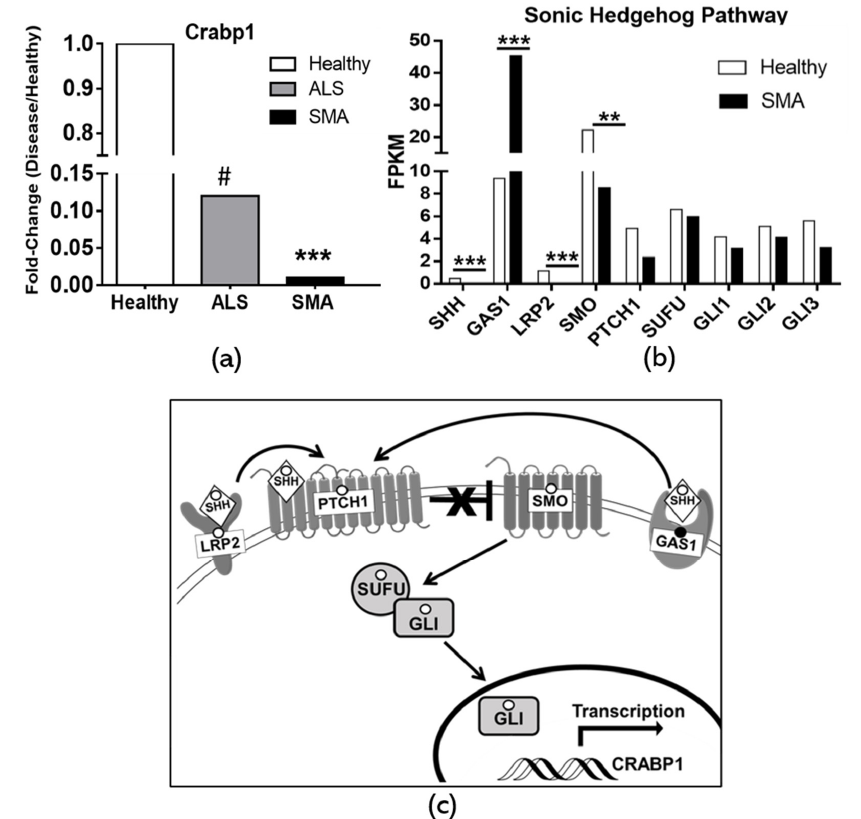
Figure 5. Dysregulation in CRABP1 and Shh signaling components in human motor neuron diseases. ( a ) Crabp1 gene expression is significantly reduced in patient-derived motor neurons. CRABP1